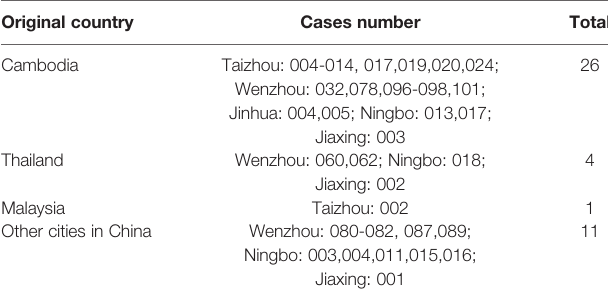
TABLE 2 | Distribution of countries of origin for imported dengue cases.